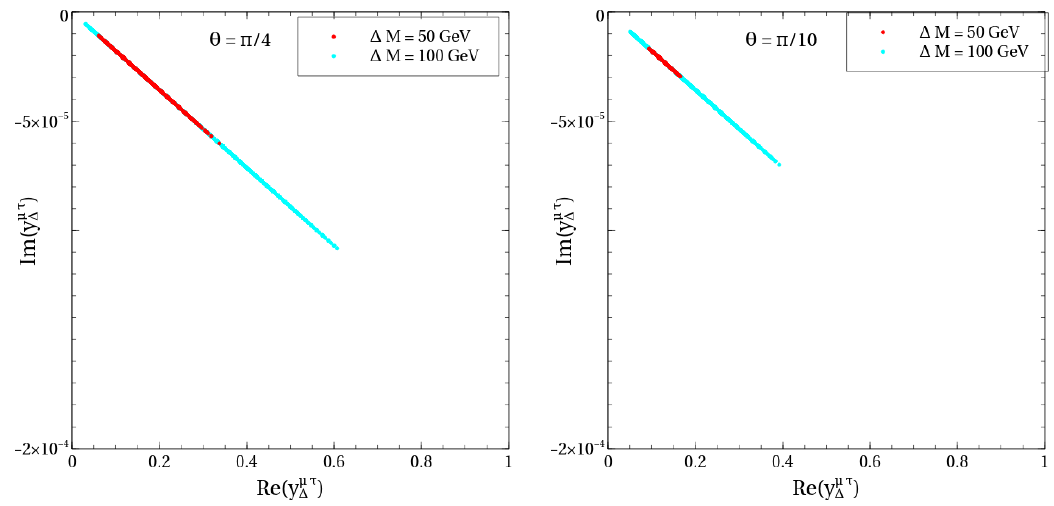
Figure 10 . Scatter points maintaining (cid:1) a (cid:22) within its 2 (cid:27) range and BR (cid:28) ! (cid:22) (cid:22)ee within the quoted limit plotted in the Re( y (cid:22)(cid:28) mass hierarchy is assumed. The color coding is explained in the legends.